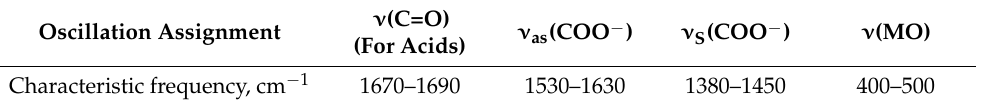
Table 1. Characteristic oscillation frequencies in IR spectra of metal carboxylates (M is metal) [36,37]. Oscillation Assignment Characteristic frequency, cm −